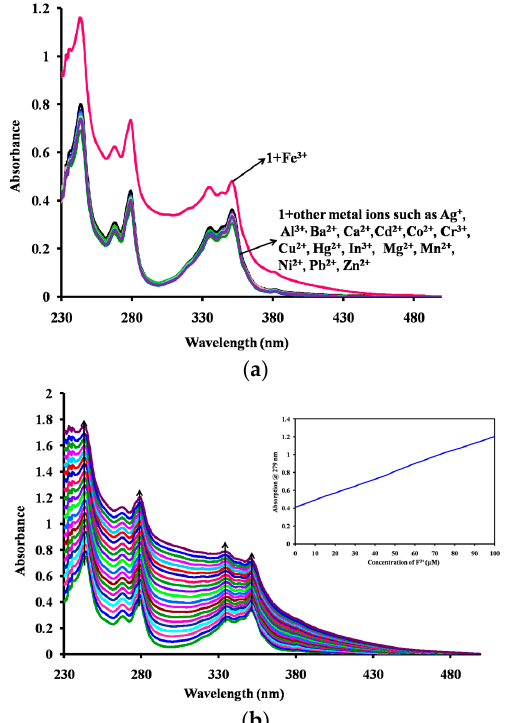
Figure 2. ( a ) UV-vis absorption spectra of receptor 1 (c = 1.0 × 10 − 5 M) upon the addition of metal ions (10 equiv.); ( b ) Receptor 1 –Fe 3+ ion at 0–10 equiv. Fe 3+ ratios where receptor 1 c = 1.0 × 10 − 5 M; Inset-linear plot of intensity vs. concentration at 279-nm wavelength.